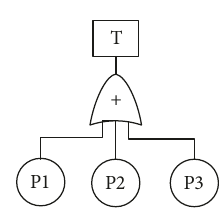
Figure 1: OR gate operator with three bottom